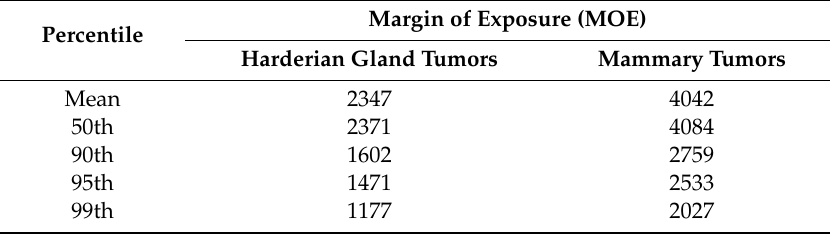
Table 5. Margin of exposure (MOE) for genotoxicity and carcinogenicity due to dietary exposure to acrylamide. Margin of Exposure (MOE) Percentile Harderian Gland Tumors Mammary Tumors Mean 2347 4042 50th 2371 4084 90th 1602 2759 1471 2027 mammary tumors (0.31 mg/kg BW/day).